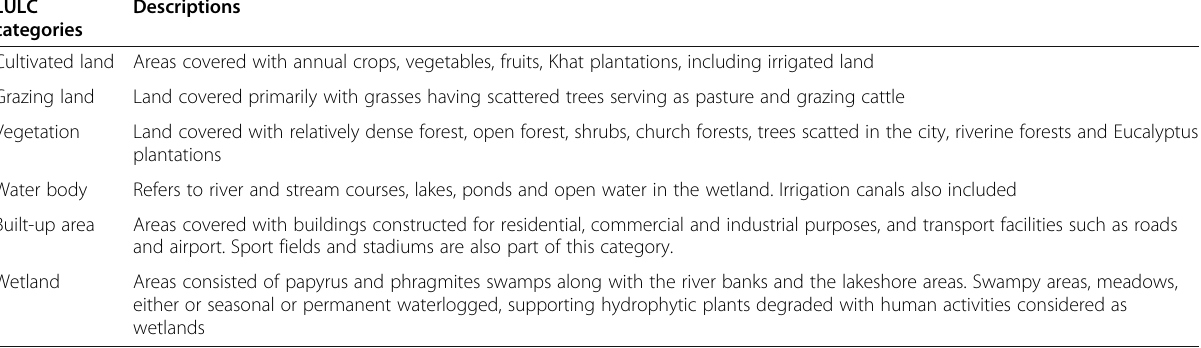
Table 2 The land use/land cover (LULC) categories of Bahir Dar City and their descriptions LULC Descriptions categories Grazing land